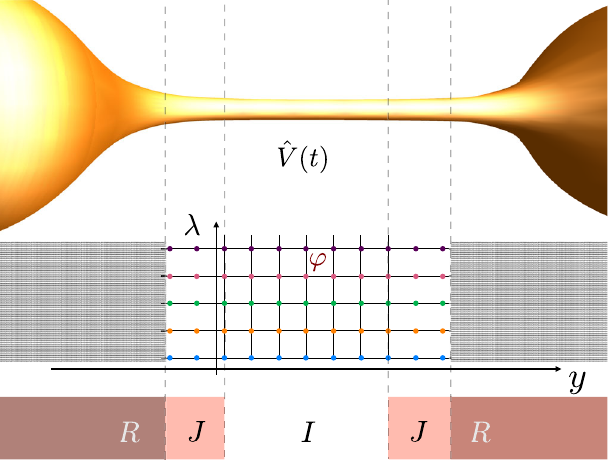
FIG. 5. Connecting the fictitious 2D system to two reservoirs: ( I ) the inner system where the time modulation (resulting in a fictitious 2D lattice defined in the λ - y plane), ( R ) the two reservoirs, and ( J ) the two junction regions (where coupling between the λ states is absent). Particles leave a reservoir to enter a nonshaken junction region (where the populations of the λ states rely only on the Fermi-Dirac distribution associated with the reservoir); particles then leave the junction to enter the inner system in an adiabatic manner.